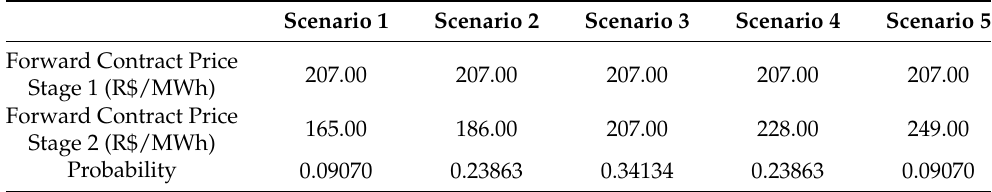
Table 1. Forward contract price scenarios.